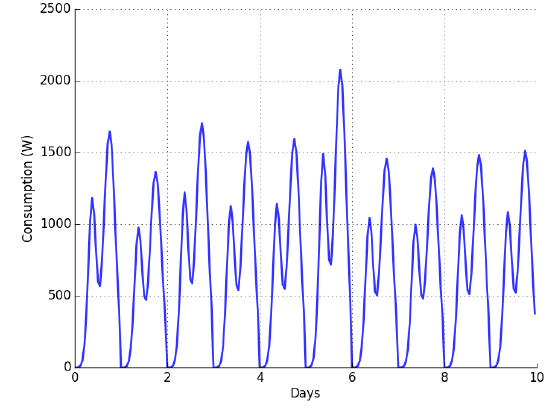
Fig. 8. Representative residential consumption profile for Belgium off-grid MG